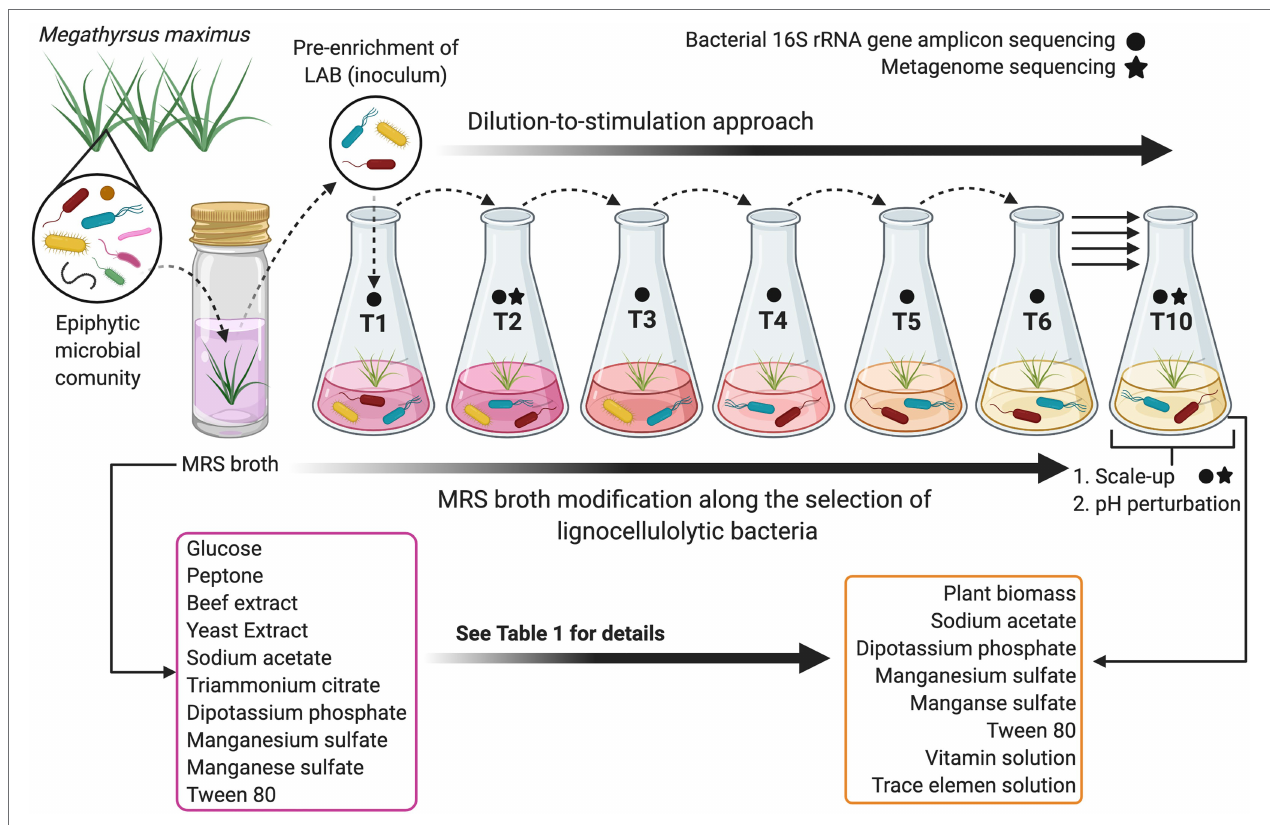
FIGURE 1 | Schematic representation of the top-down enrichment strategy by using the dilution-to-stimulation approach. During the selection process, the liquid Man, Rogosa, and Sharpe (MRS) medium, which is specific for lactic acid bacteria (LAB), was modified as shown in Table 1 in order to select lignocellulolytic bacteria (LB) from the Megathyrsus maximus phyllosphere. The scale-up and pH perturbation were carried out after transfer 10 (T10). Created with BioRender.com.